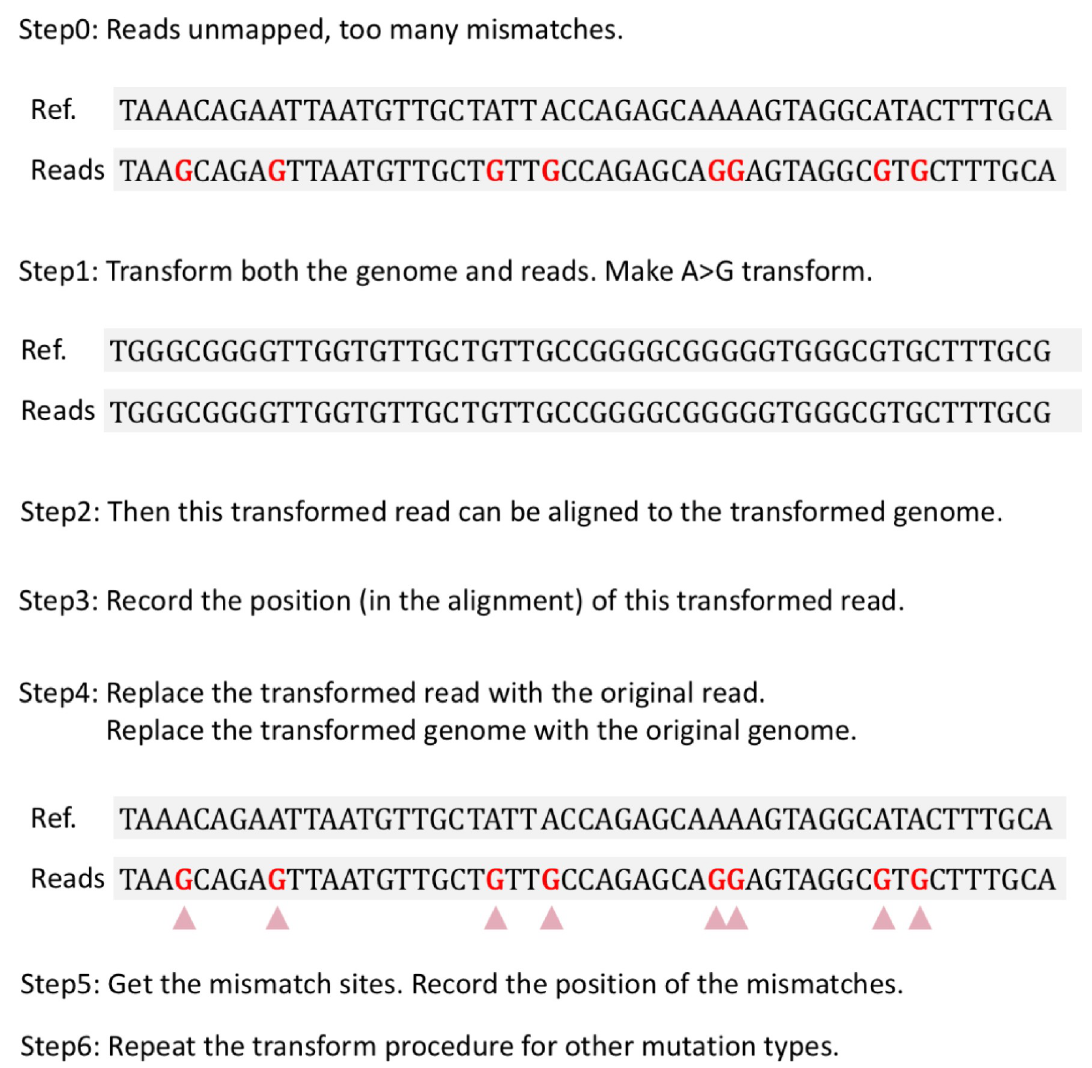
Fig 1. The transform strategy of mapping the reads with multiple